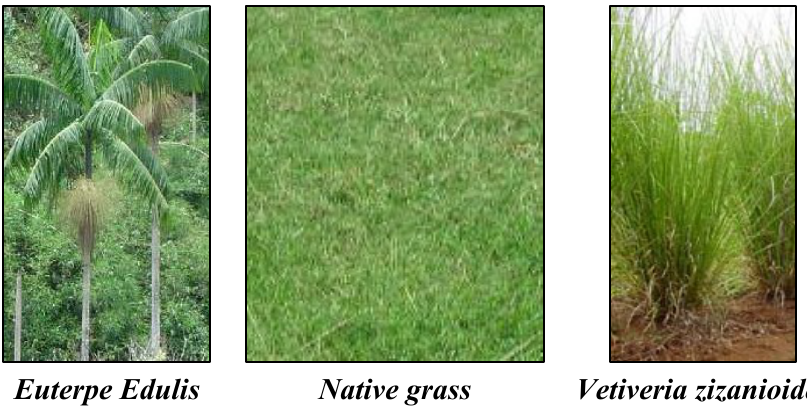
Figure 6. Species used for vegetal protection and emission compensation.